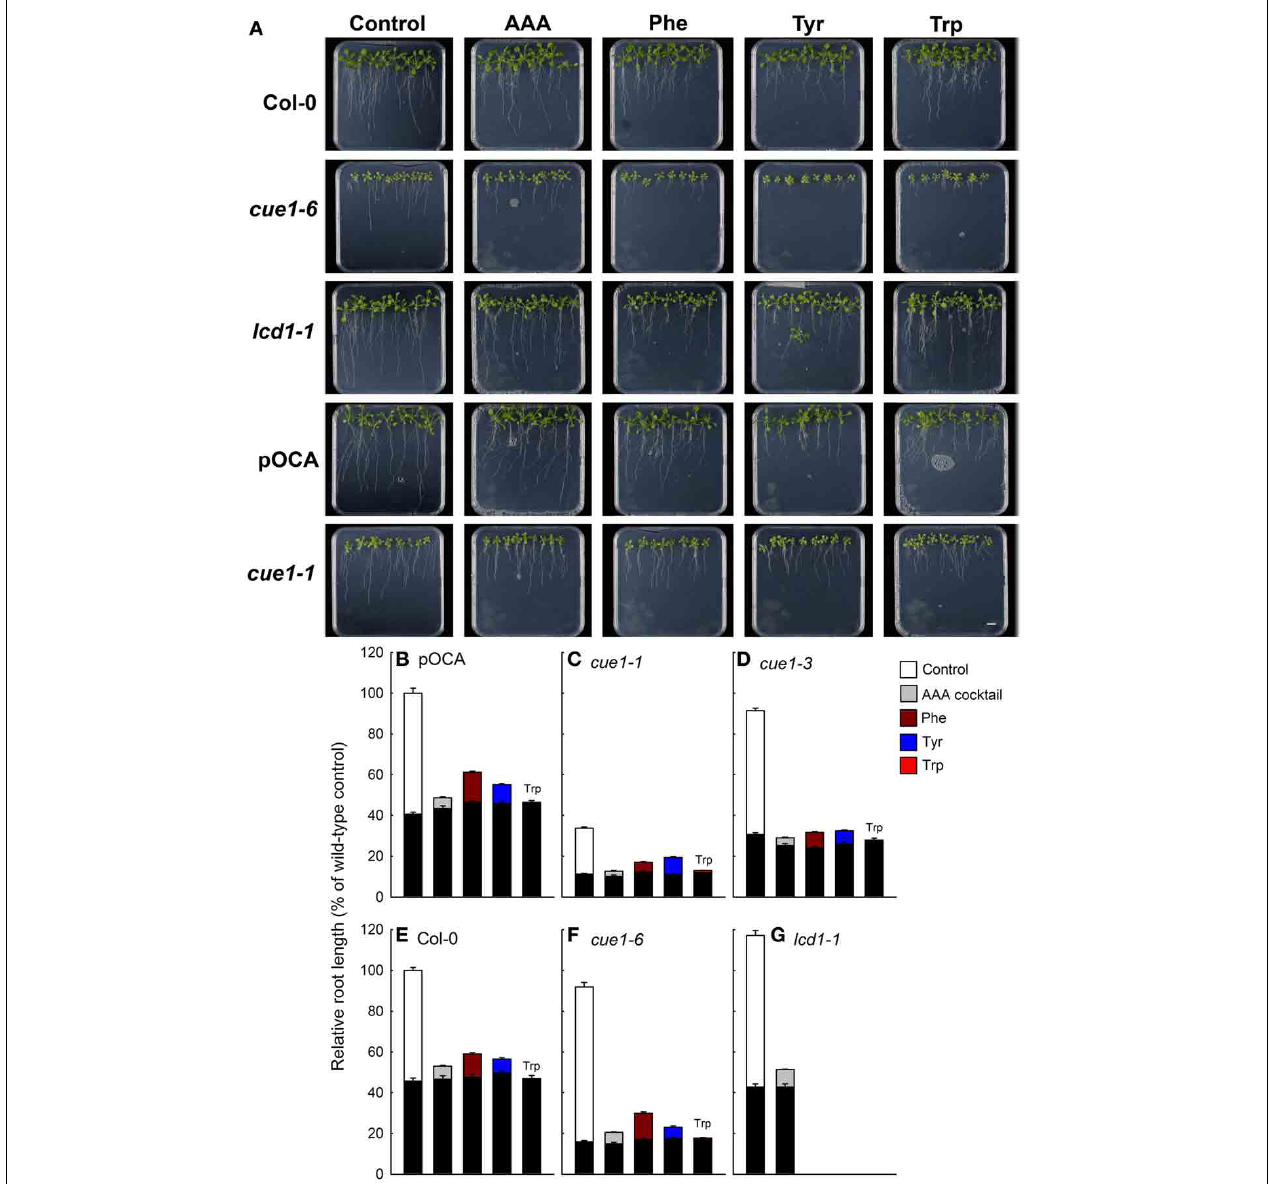
FIGURE 7 | Root phenotypes seven days after feeding of Col-0, pOCA, cue1-1 , cue1-6 , and lcd1-1 with individual AAA or a cocktail of AAA compared to unfed control plants. The plants were grown for three weeks on ½MS agar and were then transferred to ½MS agar supplemented with the effectors (2mM each). (A) Phenotypic appearance including root lengths of wild-type/control and mutant plants seven days after start of feeding with AAA (the bar indicates a